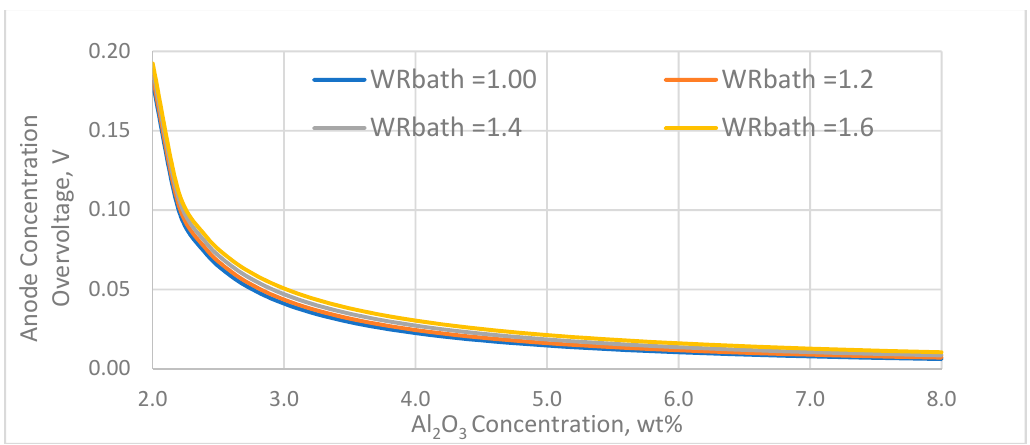
Figure 4. The effect of Al 2 O 3 concentration and bath ratio on anode concentration overvoltage.